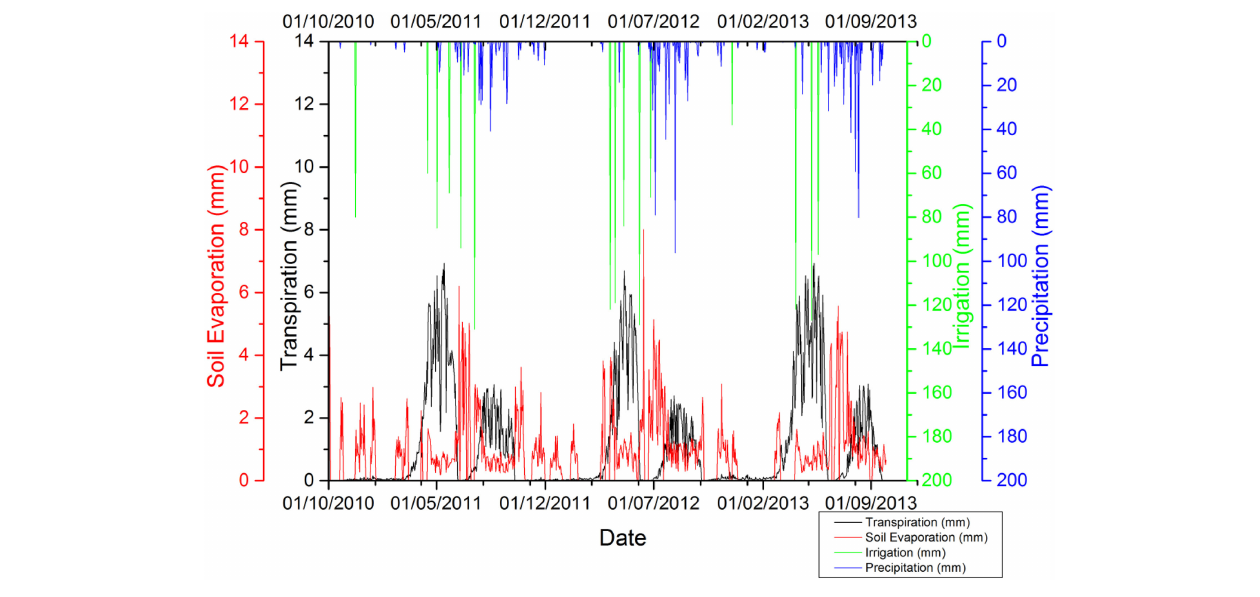
FIGURE 6 | Simulated ET a partition results of winter wheat and summer maize 2010–2011 to 2012–2013.